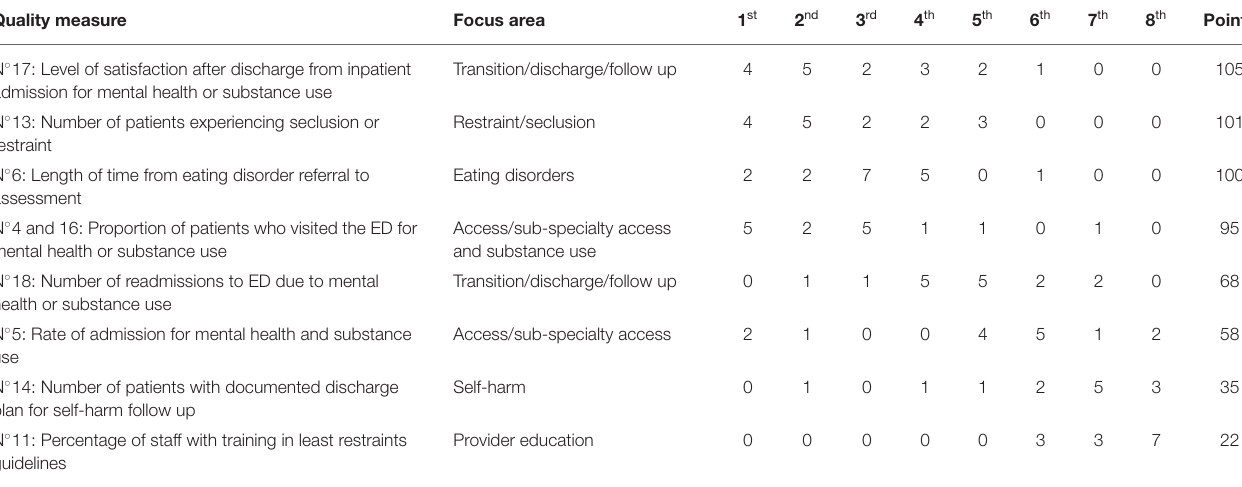
TABLE 3 | Frequencies of ranks and point allocation of quality measures. Quality measure Focus